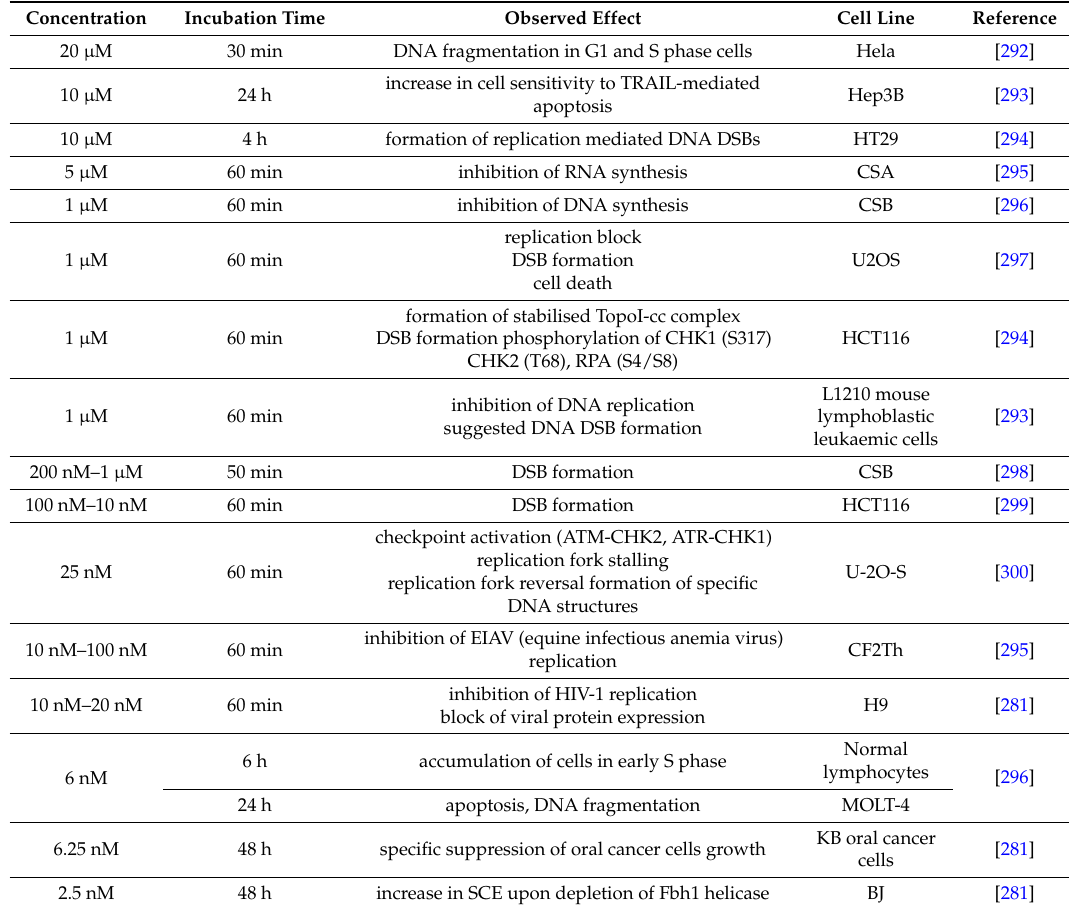
Table 4. Effects of various camptothecin treatments in